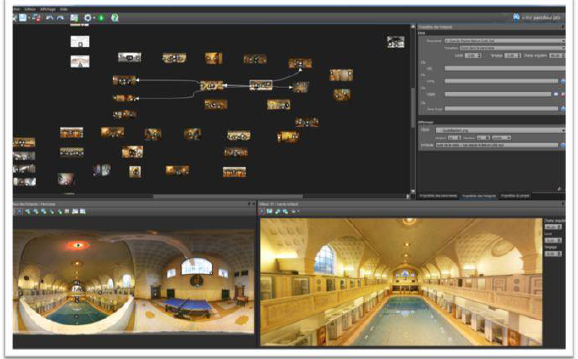
Figure 11: Panotour pro (Kolor) GUI for tour